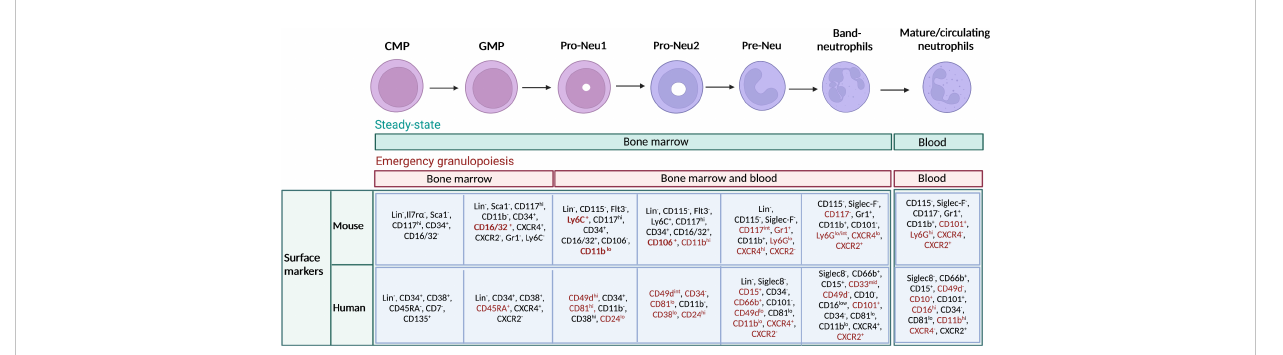
FIGURE 1 Maturation stages of neutrophils and immunophenotype in mouse and human. Schematic representation of neutrophil developmental stages in the bone marrow (BM), with associated known markers in human and mouse. Neutrophils arise from hematopoietic stem cells (HSCs) in the BM, which give rise to multipotent progenitors, then common myeloid progenitors (CMPs), granulocyte – monocyte progenitors (GMPs), and subsequently to neutrophil-committed precursors. In the BM, GMPs mature into proNeus and then into preNeus, which differentiate into band neutrophils. Finally, non-proliferative mature neutrophils are released in the circulation. Green bar indicates the location of neutrophil progenitors during steady state. Red bar indicates the location where neutrophil progenitors can be found during emergency granulopoiesis. Markers that particularly characterize a stage of differentiation or the transition from one stage to another have been highlighted in red. Gr1 represents a cell marker that includes both Ly6C and Ly6G. However, anti-Gr1 monoclonal antibody reacts strongly with Ly6G. and weakly with